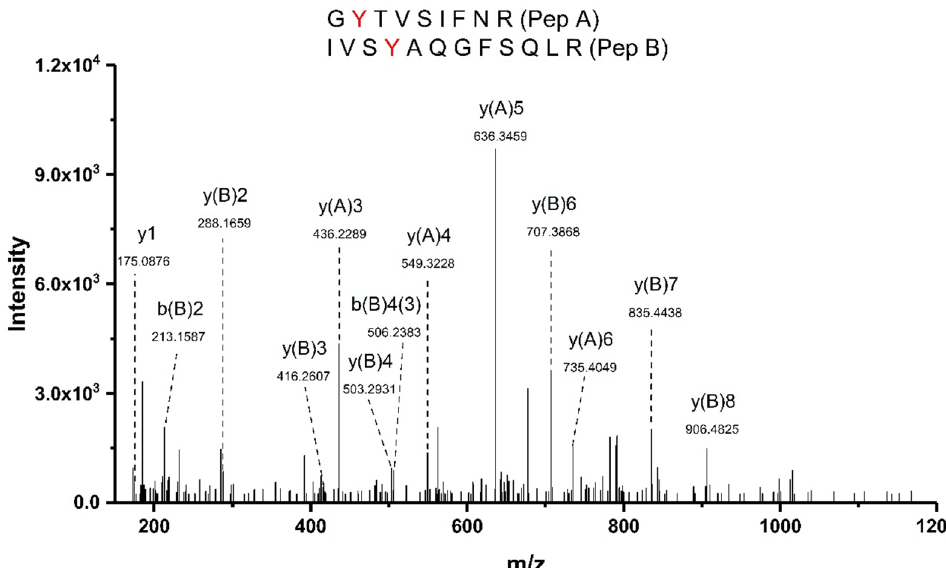
Figure 9. Formation of di-Tyr crosslinks partially explains the detection of aggregates formed on incubation of 6PGDH with 100 mM AAPH at 37 °C for 180 min. MS/MS spectrum of the quadruply charged crosslinked